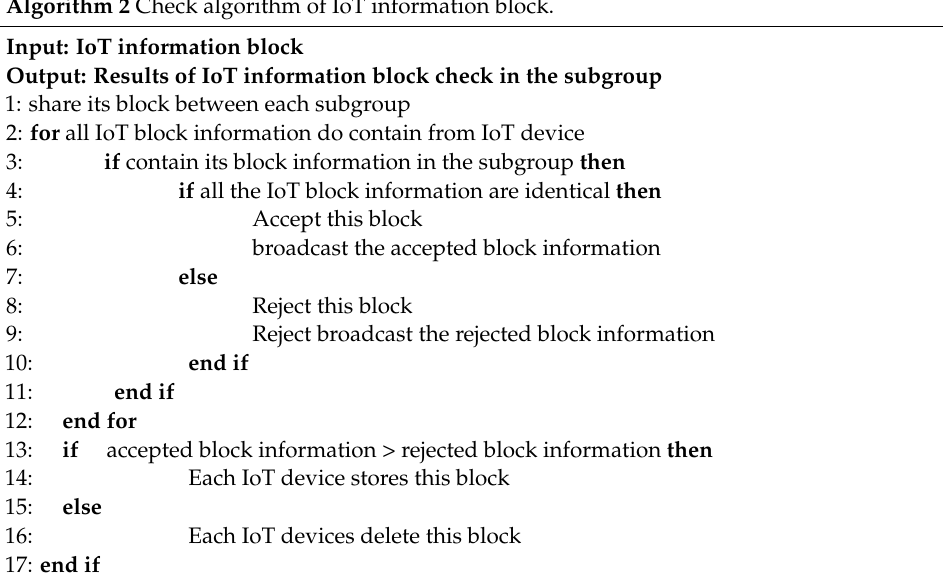
Algorithm 2 Check algorithm of IoT information